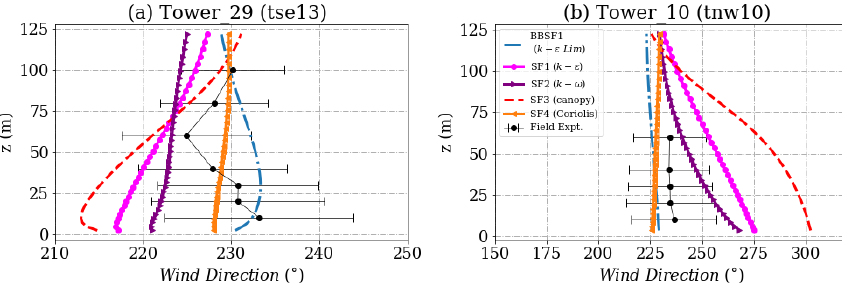
Figure 18. Simulation results and experimental data for wind direction on the northeast ridge for (a) Tower 29 (tse13) and (b) Tower 10 (tnw10). The locations of the masts are given in Fig. 2.